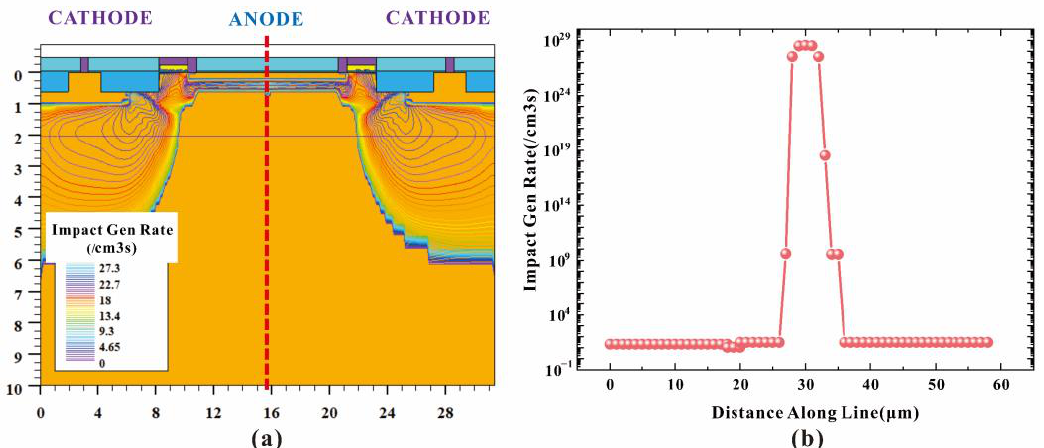
Figure 2. Two-dimensional impact ionization distribution of HDEPD device ( a ) and one-dimensional tangent distribution of impact ionization for HDEPD device ( b ).